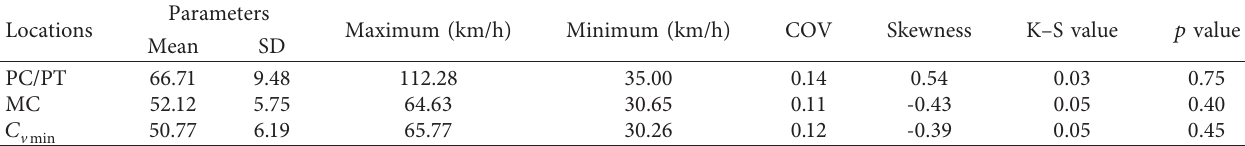
Table 7: Descriptive statistics and K–S test results.